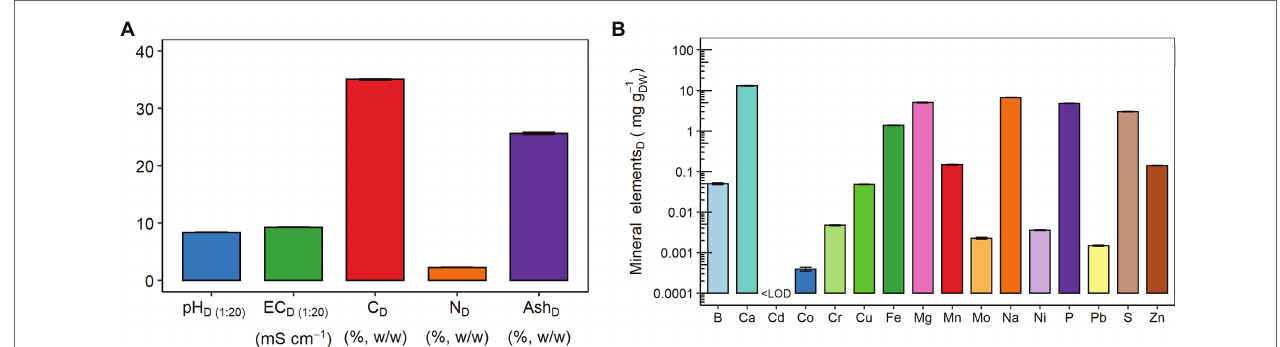
FIGURE 1 | Chemical properties of the digestate (D): (A) pH, electrical conductivity (EC), carbon (C), nitrogen (N), and ash contents; and (B) mineral element concentrations: boron (B), calcium (Ca), cadmium (Cd), cobalt (Co), chromium (Cr), copper (Cu), iron (Fe), magnesium (Mg), manganese (Mn), molybdenum (Mo), sodium (Na), nickel (Ni), phosphorus (P), lead (Pb), sulfur (S), and zinc (Zn). LOD, limit of detection. The LOD of Cd was 0.177 μ g L − 1 . Data are presented as means ± SE ( n = 3). Data of mineral element concentrations are presented on a logarithmic scale (Log 10 ) for better graphical display, and the values are detailed in Supplementary Table 1